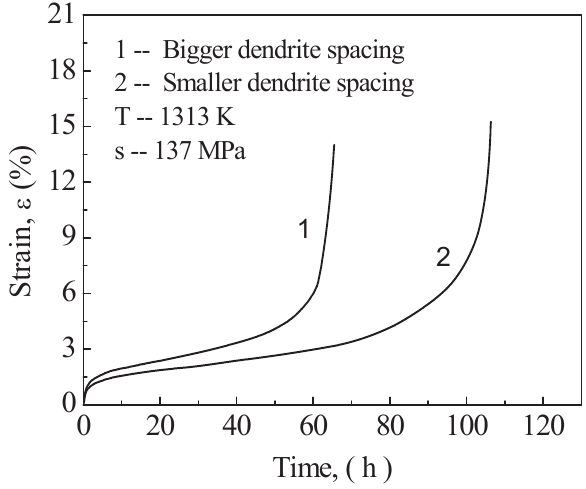
Figure 3. Creep curves of the alloys 1 and 2 with different dendrite spacings at 137 MPa = 1313